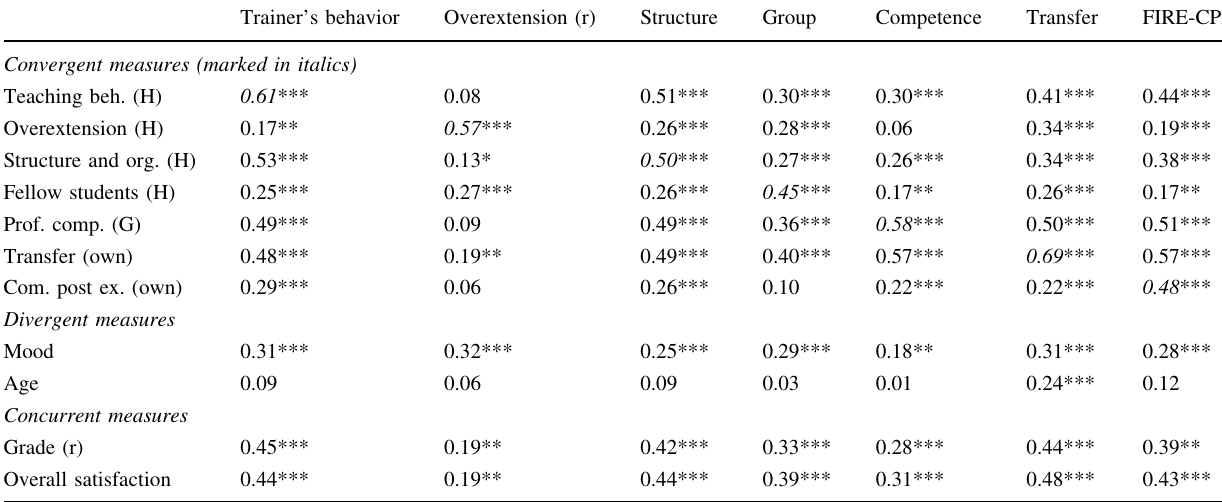
Table 3 Correlations with validation measures Trainer’s behavior Overextension (r) Structure